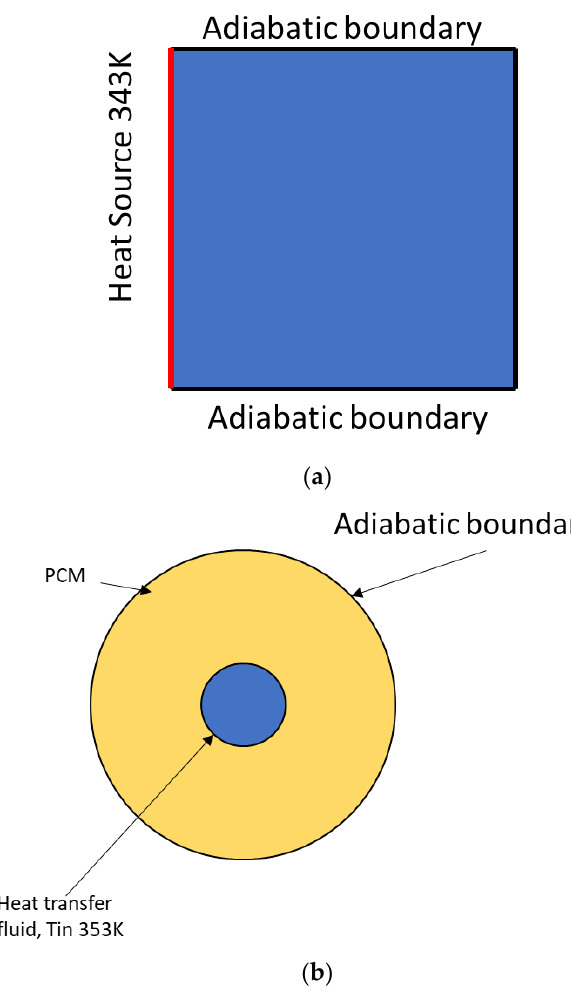
Figure 1. The analysis domain: ( a ) Rectangular domain of L = 5 cm with three adiabatic walls; ( b ) Concentric tube heat exchanger with inner tube diameter d = 22 mm and outer tube diameter D = 125 mm.